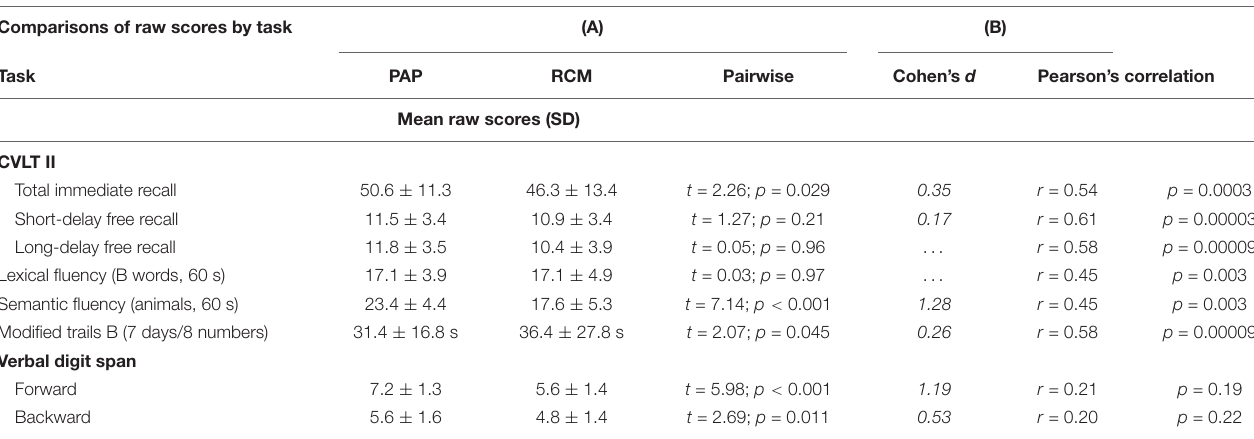
TABLE 2 | Results for comparisons of PAP and RCM versions of each